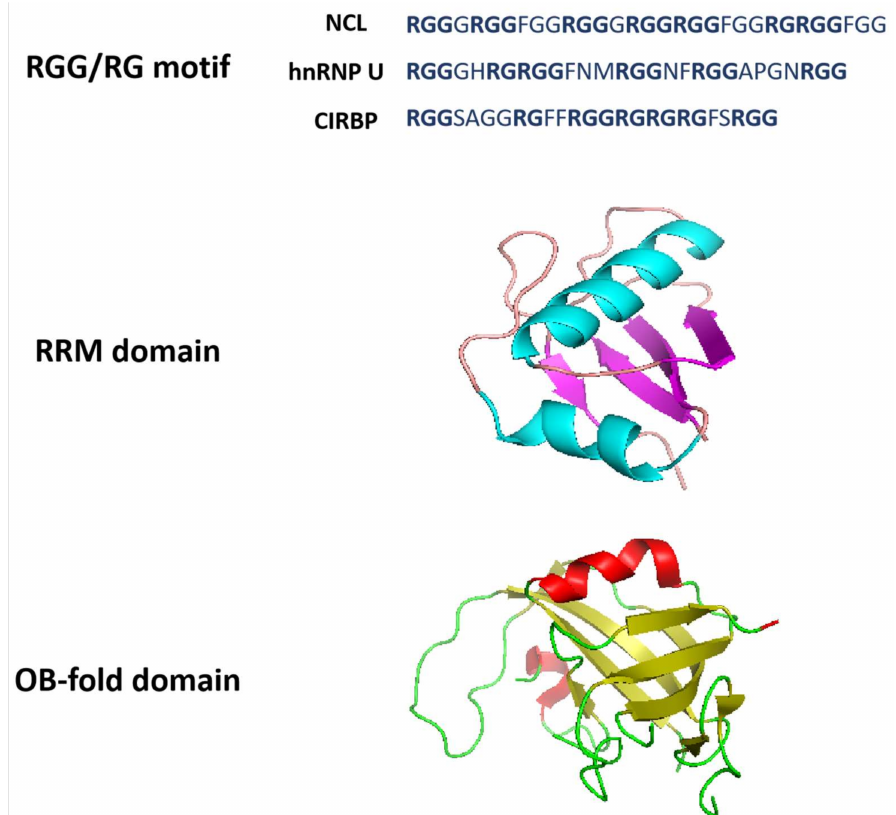
Figure 4. Structural properties of G-quadruplex-binding proteins. RGG/RG motifs are from NCL, hnRNP U and CIRBP. The RRM domain structure is derived from Protein Data Bank with structure code 2KRR (NCL) [112]. RRM domain is an αβ sandwich structure composed of one four-stranded antiparallel β -sheet and two α -helices packed against the β -sheet. The OB-fold domain structure is derived from Protein Data Bank with structure code 5W2L (CTC1) [113]. OB-fold domain is a β -barrel formed by five antiparallel β